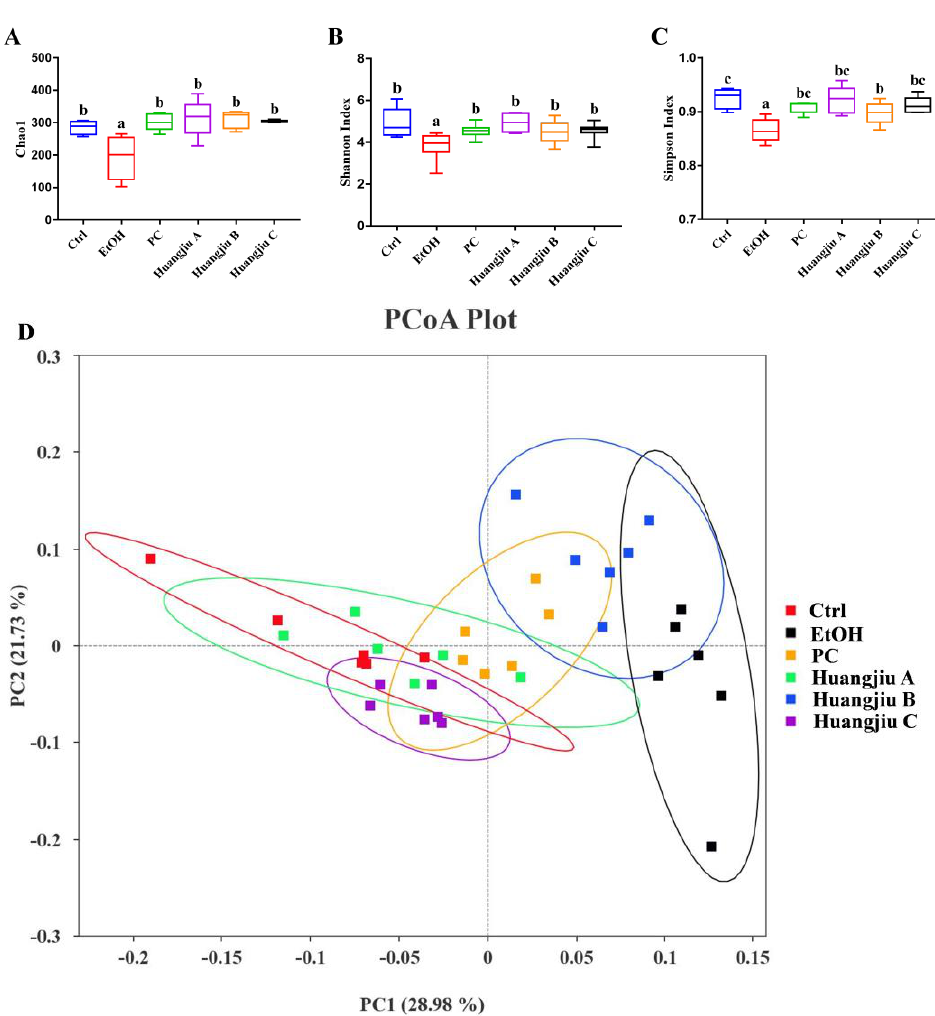
Figure 4. Effects of Huangjiu interventions on α -diversity and β -diversity of gut microbiota. ( A ) Chao1 richness index of gut microbiota. ( B ) Shannon diversity index of gut microbiota. ( C ) Simpson diversity index of gut microbiota. ( D ) Weighted Unifrac PCoA plot of gut microbial communities based on the OTU data. All data expressed as mean ± standard deviation (SD) ( n = 8). Different lowercase letters indicate statistically significant differences ( p < 0.05) between the groups using one-way ANOVA followed by Fisher’s LSD test.